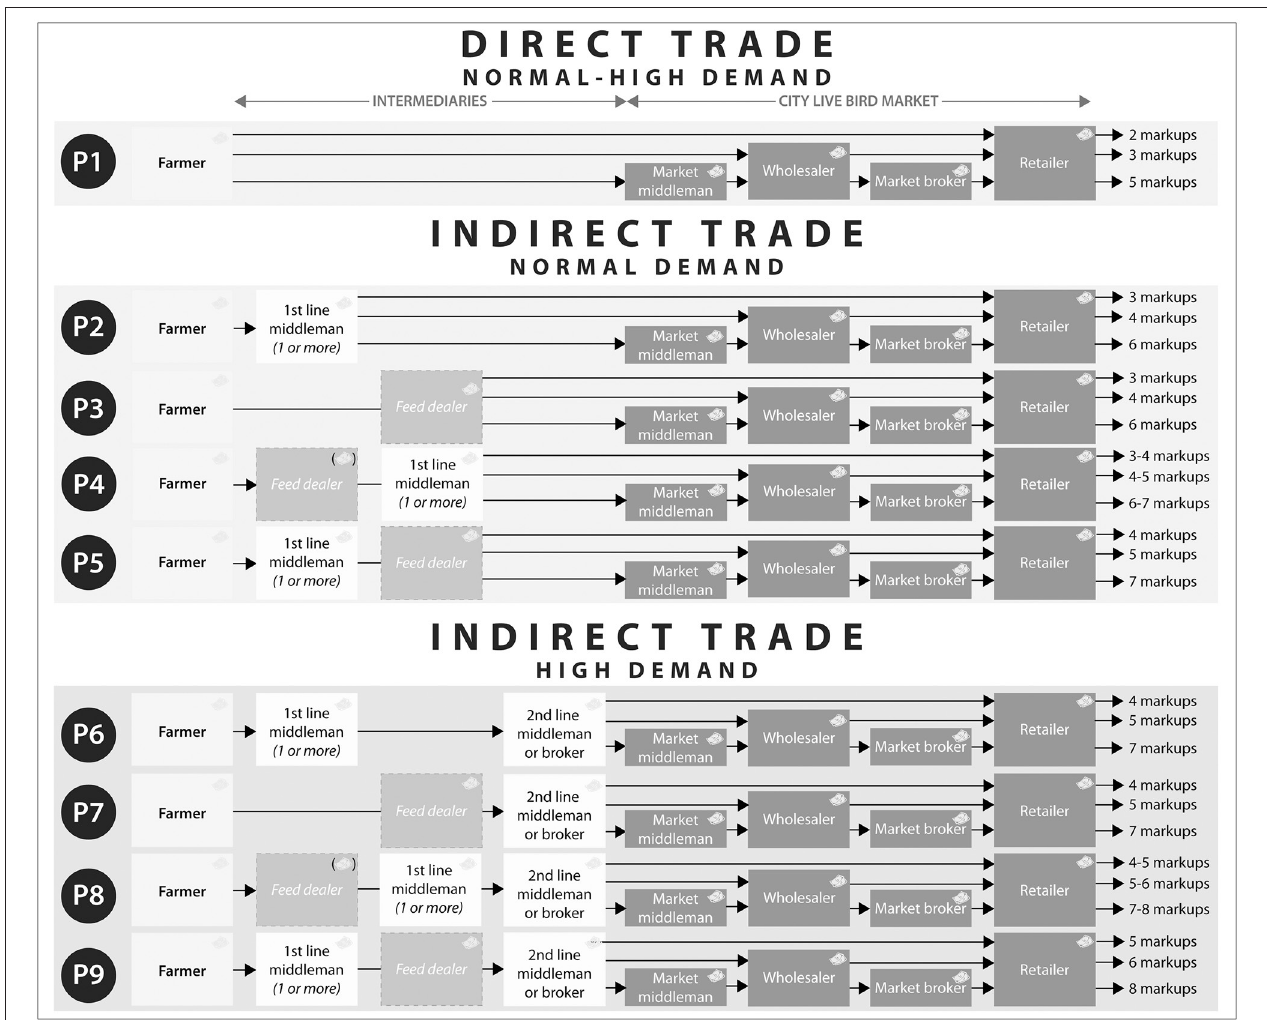
FIGURE 1 | Poultry commodity chains in Chattogram, Bangladesh. Trading patterns P4 and P8: Feed dealers may or may not ask for a fee, when they help the farmers getting in contact with first line middlemen (money icon in